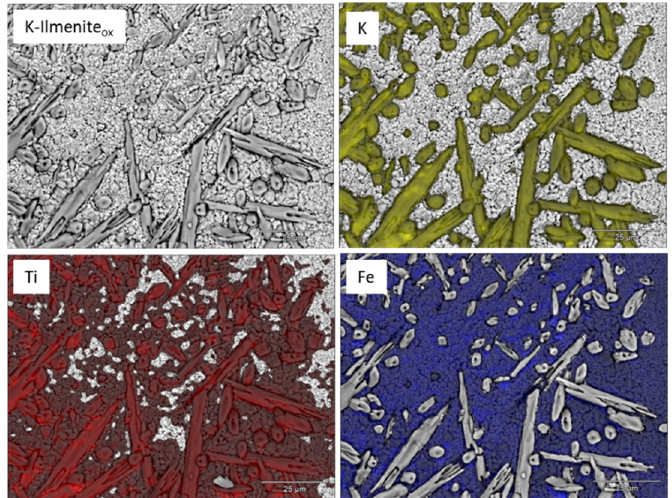
Figure 5. Back-scattered SEM image and elemental maps of oxidized K-Ilmenite ox showing K (green), Ti (red), and Fe (blue). Ti (red), and Fe (blue).